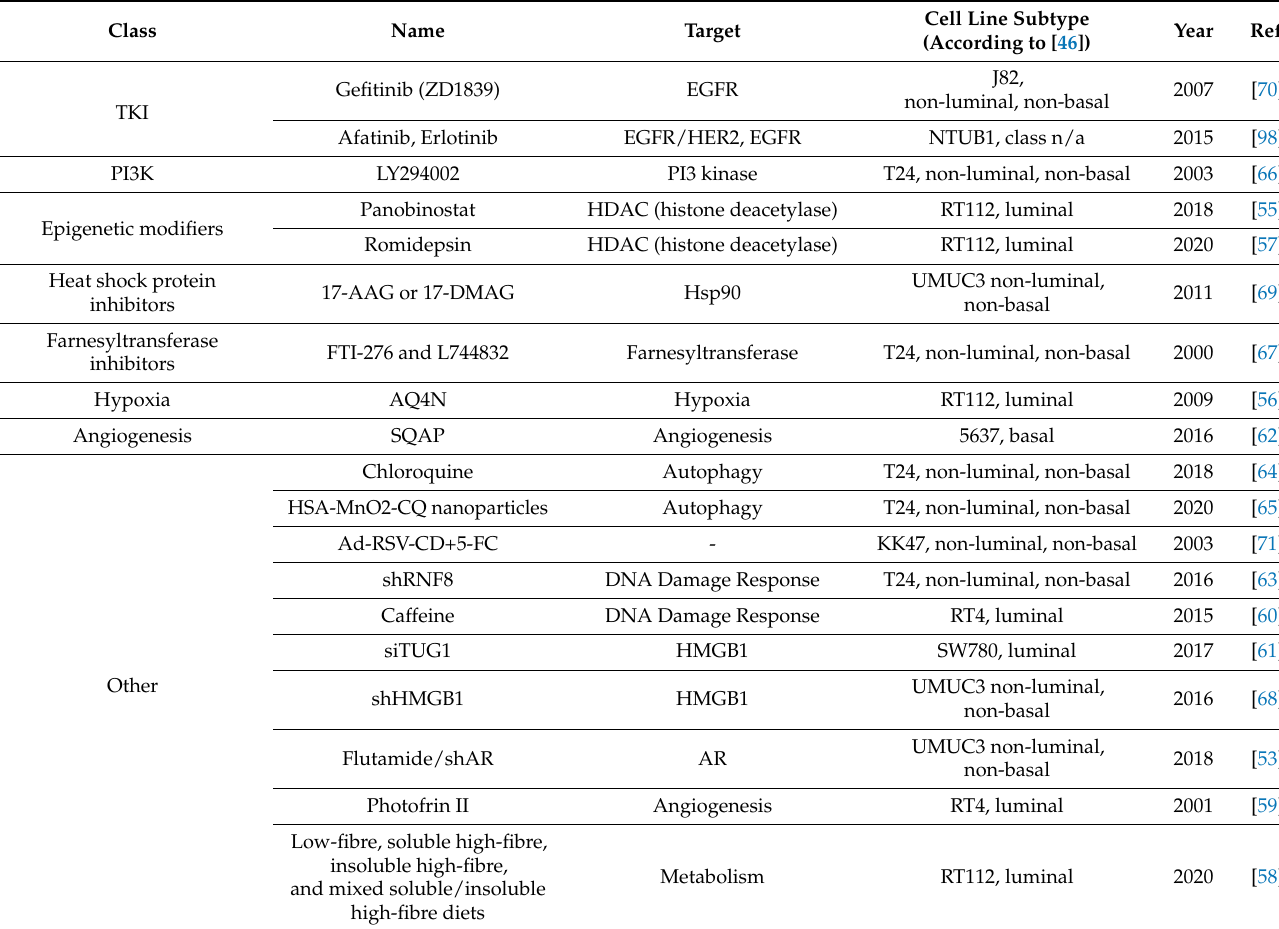
Table 7. Targeted agents used as radiosensitisers in preclinical studies using BCa